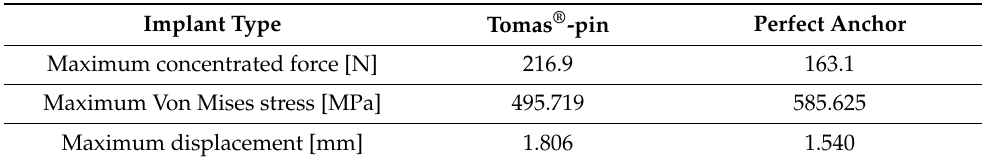
Table 3. Analysis